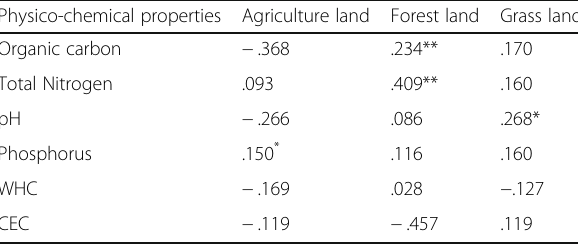
between agricultural and grassland soils was not significant.